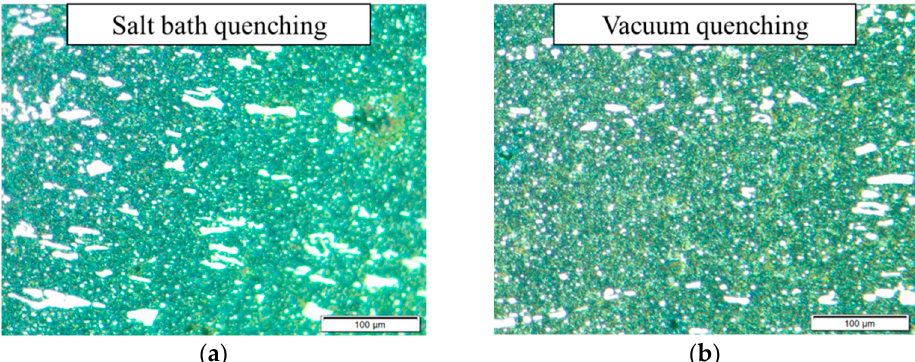
Figure 11. The metallographic structure of the disc cutter after the heat treatment: ( a ) Salt bath quenching; ( b ) Vacuum quenching.